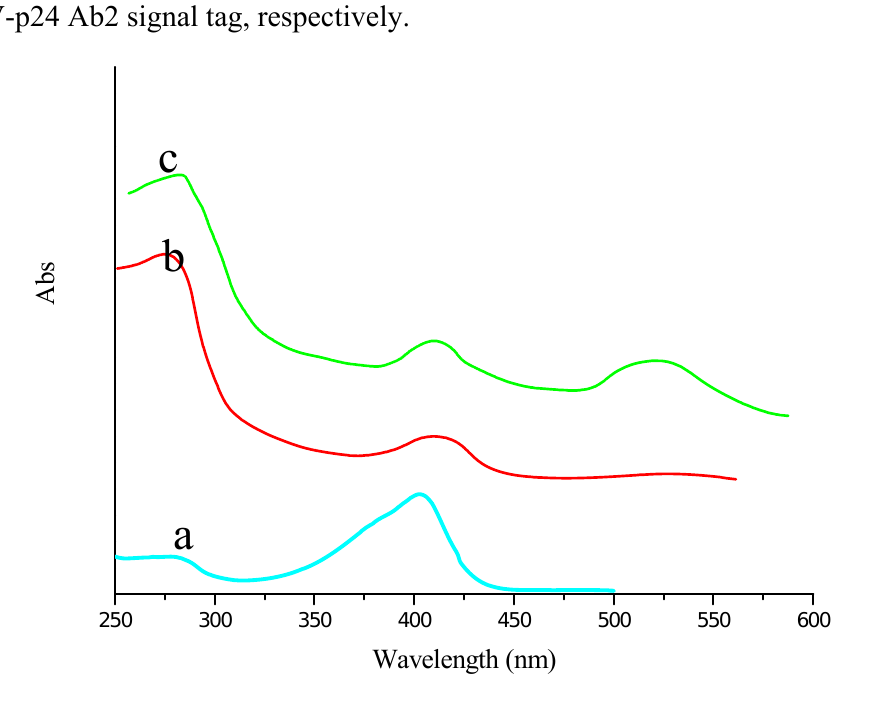
Figure 4. The ultraviolet-visible absorption spectrometry of ( a ) EV; ( b ) EV-p24 Ab2 and ( c ) Au/EV-p24 Ab2 signal tag,